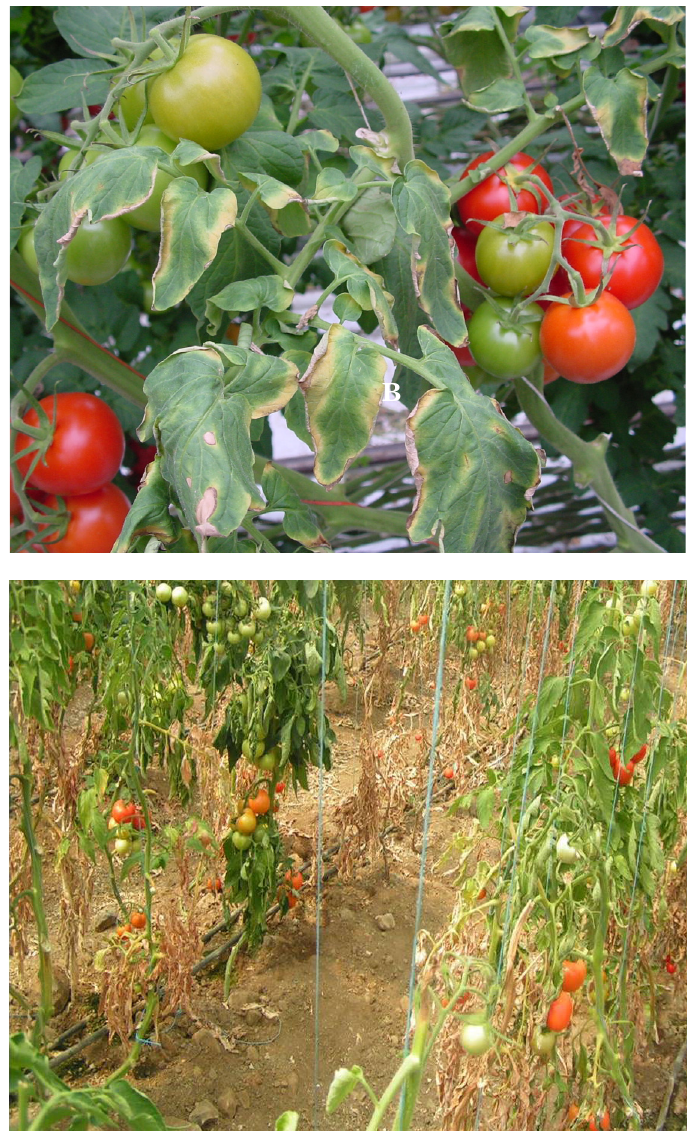
Figure 2. Symptoms seen in greenhouses. A. Discoloration of leaf margins. B. Wilting of whole